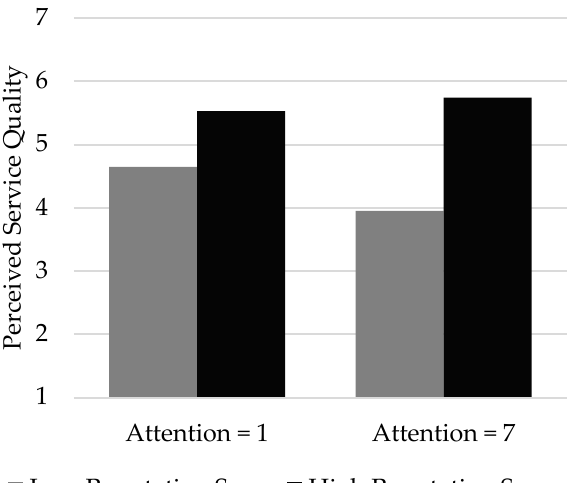
Figure 2. E ff ects of reputation score at the minimum and maximum attention Figure 2. Effects of reputation score at the minimum and maximum attention scores.